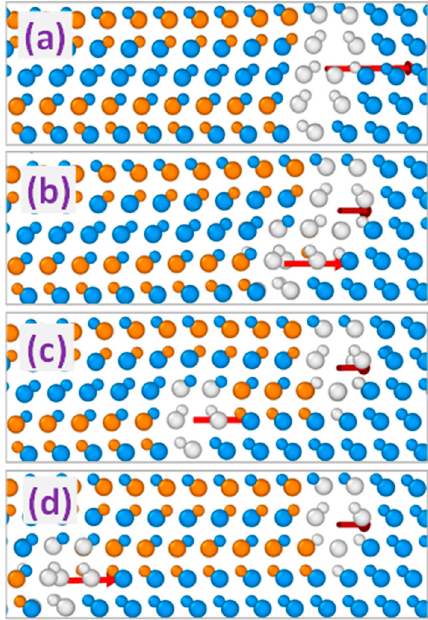
Figure 6. MD simulated evolution of the 60°-like triple dislocation complex formed by 90°-30°-90° partial dislocation sequence. Simulated time: ( a ): 0, ( b ): 30, ( c ): 60, and ( d ): 100 ps, respectively. Arrows indicate the directions of the Burgers vectors of the triple dislocation complex ( a ) as well as double dislocation complex and 90° partial dislocation ( b – d ).